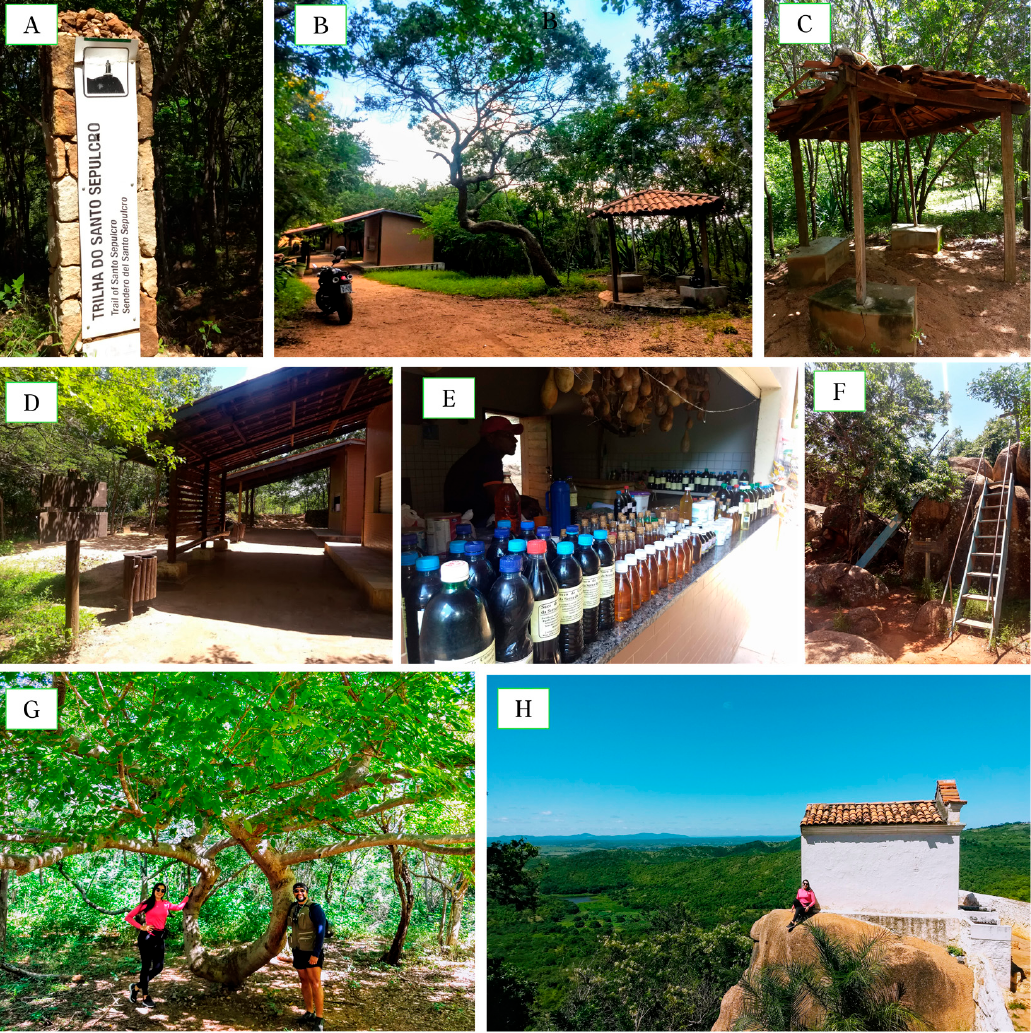
Figure 10. Santo Sepulcro trail infrastructure in Colina do Horto Geosite, Araripe UGG. Source: Research Collection. ( A )— Start trail, signage, and internal communication; ( B , C )—Rest area kiosks; ( D , E )—Points of support with the sale of regional products; ( F )—Viewpoints; ( G )—“Magic Trees” (Umbuzeiro); ( H )—“Miraculous” Chapels (Senhora Santana chapel).